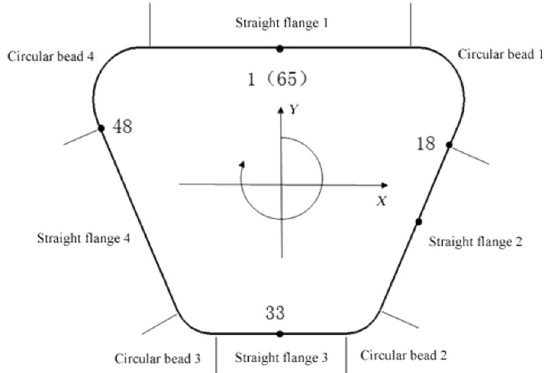
Figure 38 Schematic of the distribution of measurement points